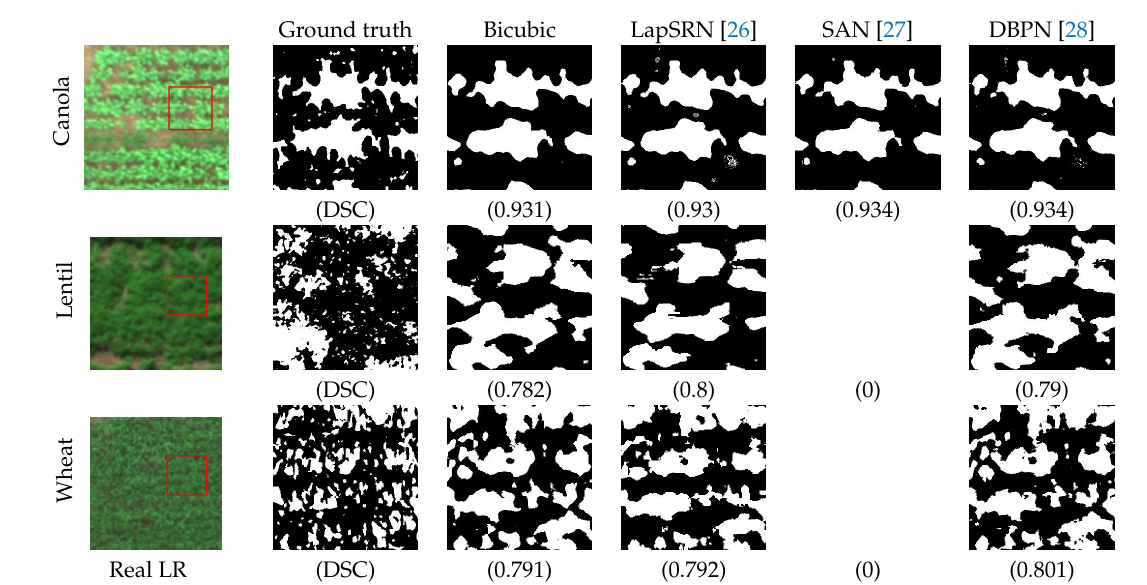
Figure 9. Example test images from the synthetic-real experiment for canola, lentil and wheat datasets (top/middle/bottom rows). Ground truth HR images (left) are shown with the cropped region denoted by a red box. Black pixels indicate vegetation segmentation (foreground) and DSC values are listed below each image.